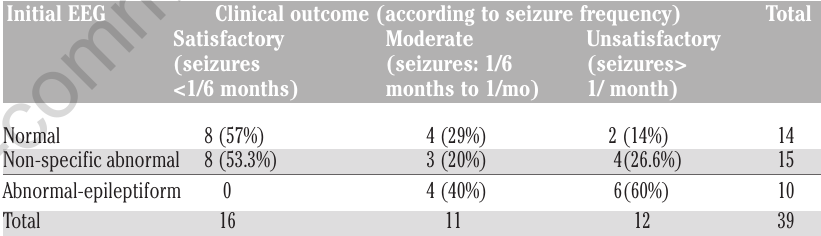
Table 2. Clinical outcomes in relation to the initial electroencephalography.